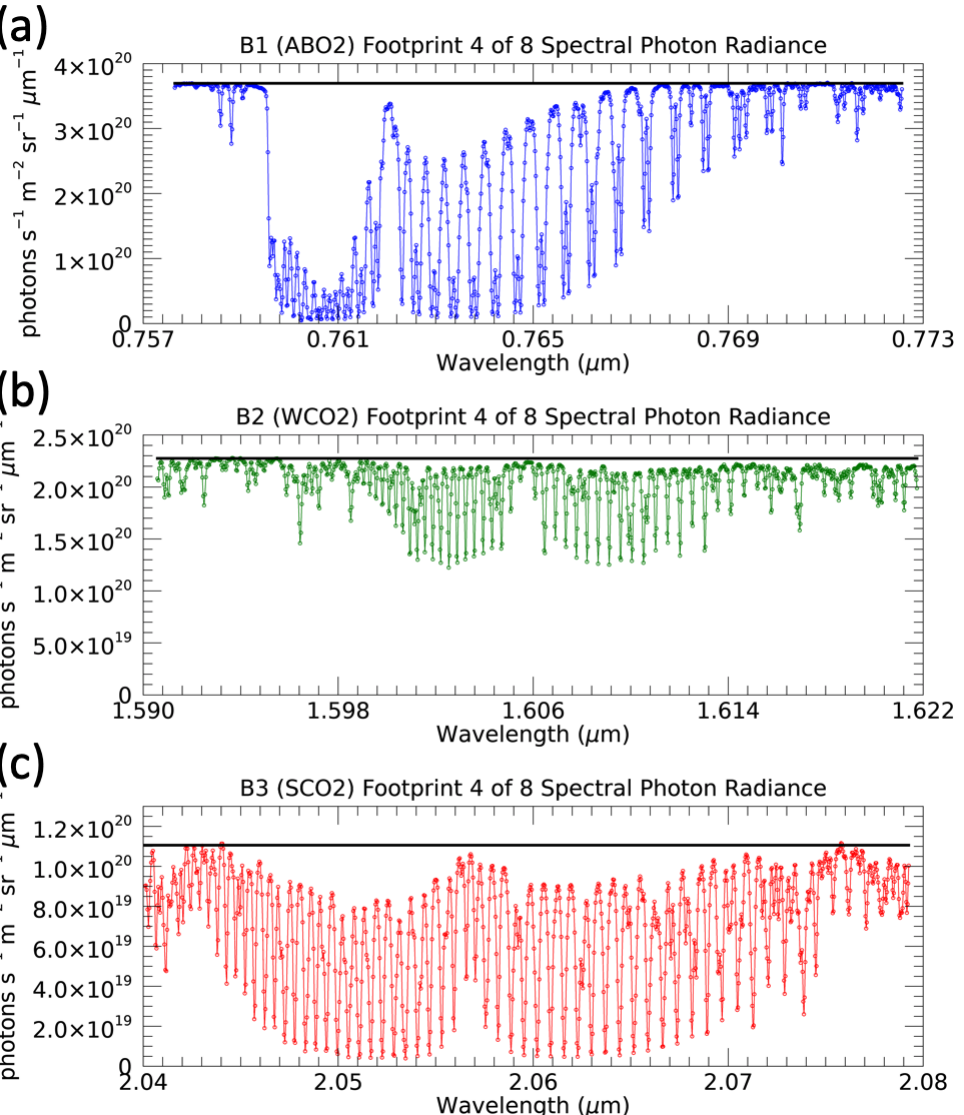
Figure 1. Examples of OCO-2 spectra taken over Egypt1 (sounding_id=2019071311331034, orbit #26754): Panel ( a ) for Band 1; Panel ( b ) for Band 2; Panel ( c ) for Band 3. The grating of each band disperses light onto 1016 spectral channels of a focal plane array, yielding three spectra with a resolution of ∆ λ ≈ 0.04, 0.08, and 0.1 nm, respectively. The black horizontal line is the average of the 10 largest radiance values, which is used to estimate the continuum signal. This OCO-2 continuum estimate is compared to the spectral radiance of the matching MODIS